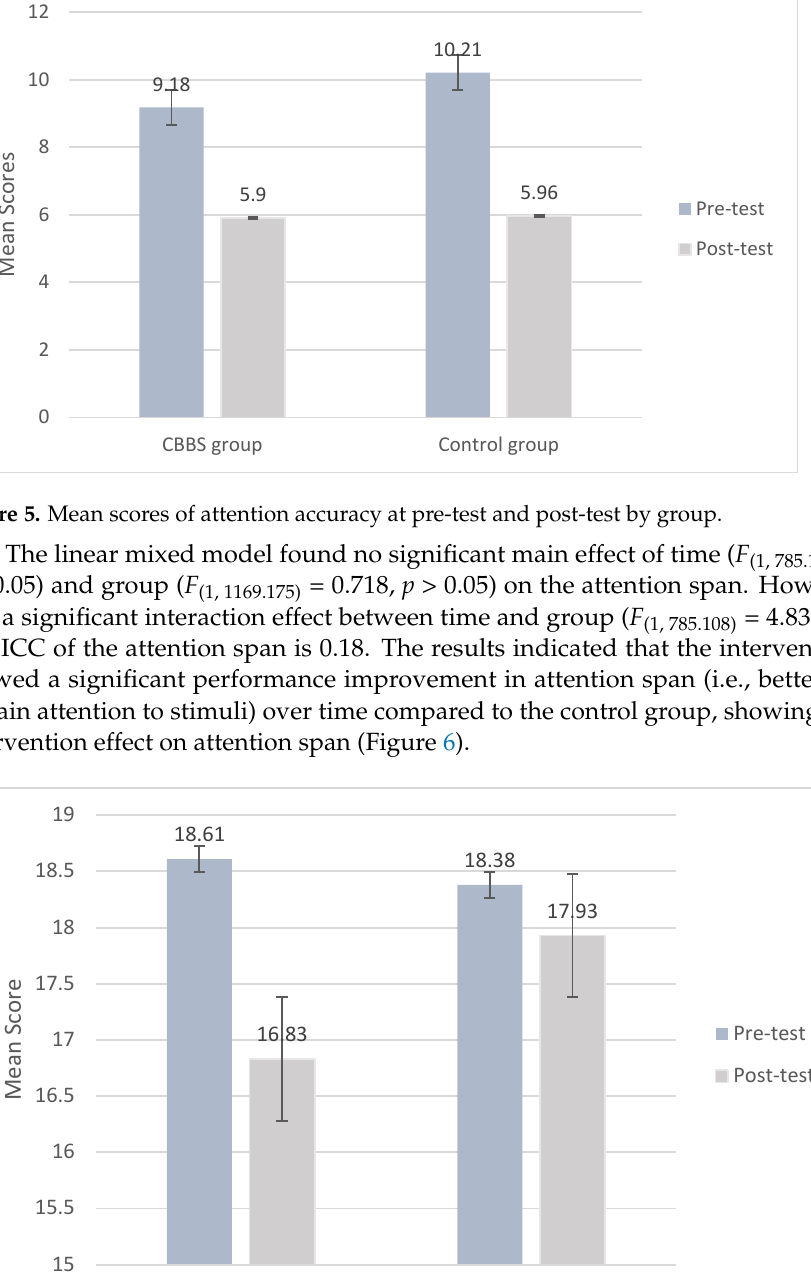
Figure 4. Mean scores of concentration at pre-test and post-test by group The linear mixed model indicated that there was a significant main effect of time in attention accuracy ( F (1, 663.124 ) = 61.542, p < 0.01), but a significant group effect ( F (1, 684.402) = 0.63, p > 0.05) or a significant interaction effect of time with group ( F (1, 663.124) = 1.021, p > 0.05) were not observed (Table 3). The ICC of the attention accuracy is 0.37. The results indicated that the two groups significantly improved their performance in attention accu- racy over time. Although, the intervention group demonstrated better performance com- was found over time (Figure 5).